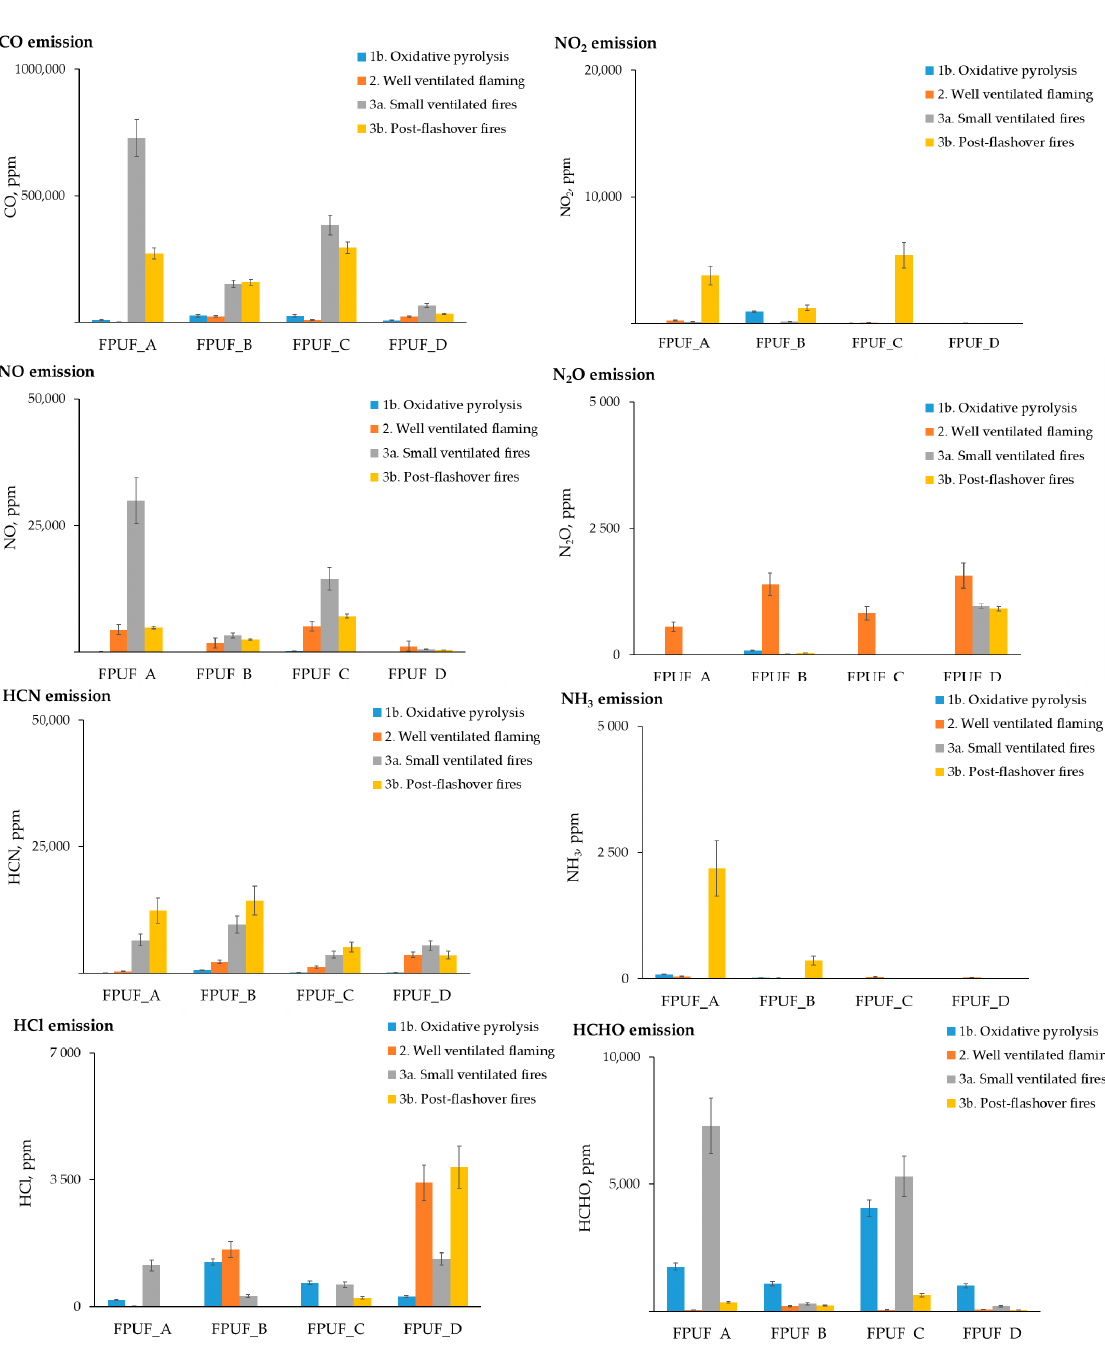
Figure 4. Total concentration of asphyxiates and irritants from steady ‐ state tube furnace tests pro ‐ duced by flexible polyurethane foams during ~5 min steady ‐ state periods.